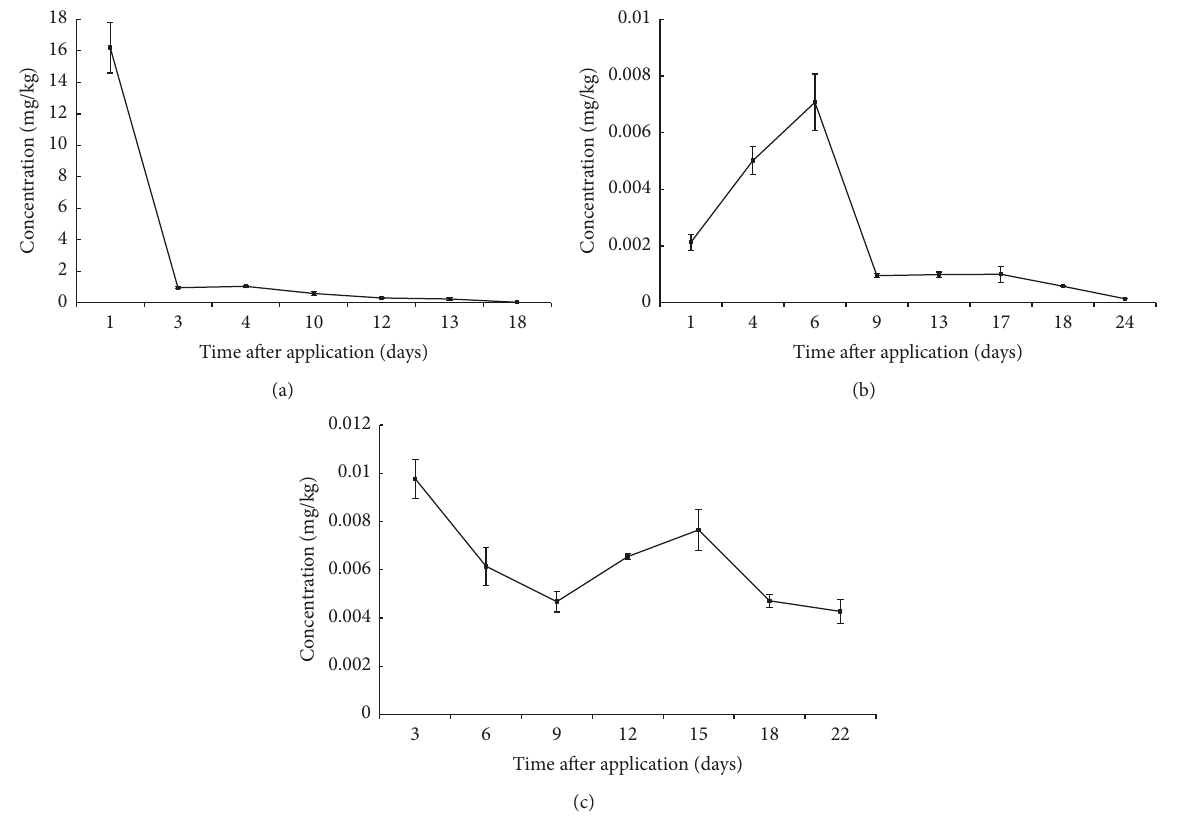
Figure 2: The concentration changes of triadimefon in apicultural products: (a) pollen, (b) honey, and (c) jelly.